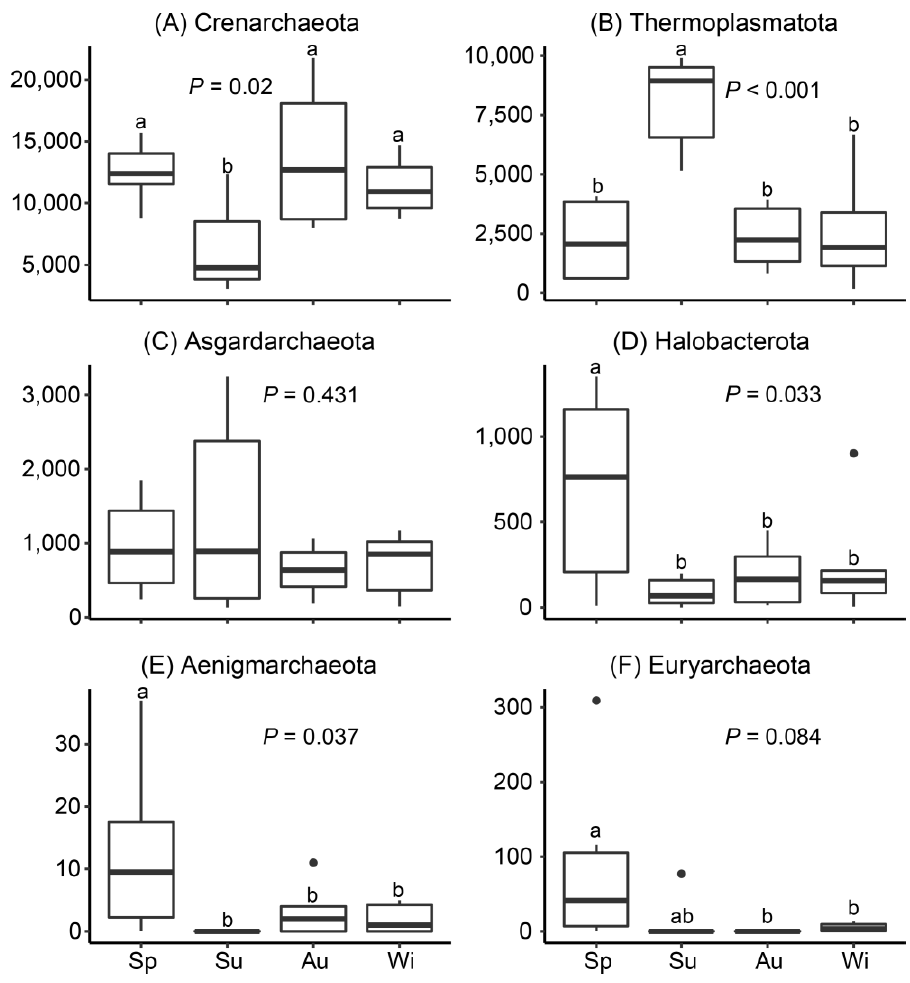
Figure 3. Comparisons of amplicon sequence variant (ASV) richness of the archaeal major phyla ( A , Crenarchaeota ; B , Thermoplasmatota ; C , Asgardarchaeota ; D , Halobacterota ; E , Aenigmarchaeota ; and F , Euryarchaeota ) among four seasons. Mean values with different letters, determined by ANOVA with LSD post hoc test ( n = 6), indicate significant differences ( p ≤ 0.05). Abbreviations: Sp, spring; Su, summer; Au, autumn; Wi,